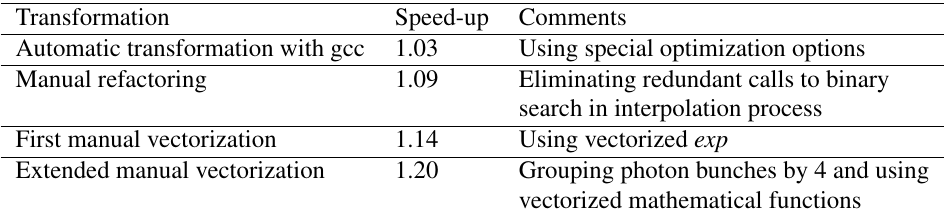
Table 1. Speed-up obtained with automatic and manual transformations of CORSIKA. The reported speed-up is the cumulated value after each transformation. For each version of the program, the accuracy has been checked by comparing the output numerical values with those obtained with a CORSIKA reference